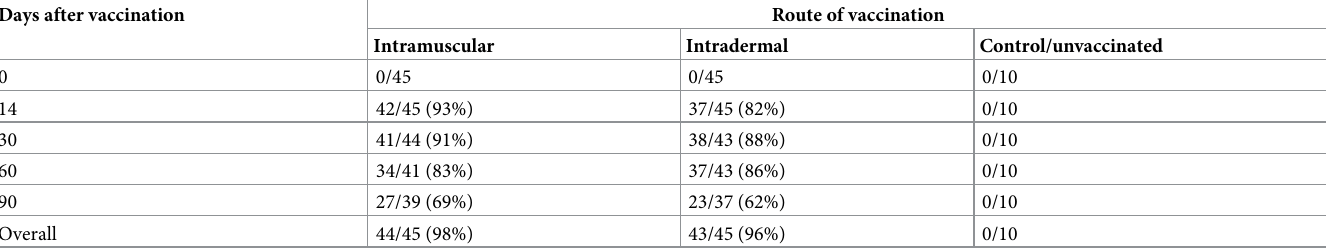
Table 2. Proportion of cattle that responded to rabies vaccination (based on VNA titre � 0.17 IU/mL). Days after vaccination